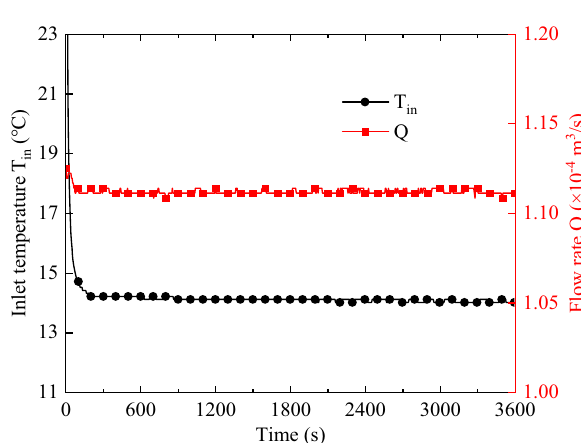
Fig. 5 Inlet temperature and inlet flow